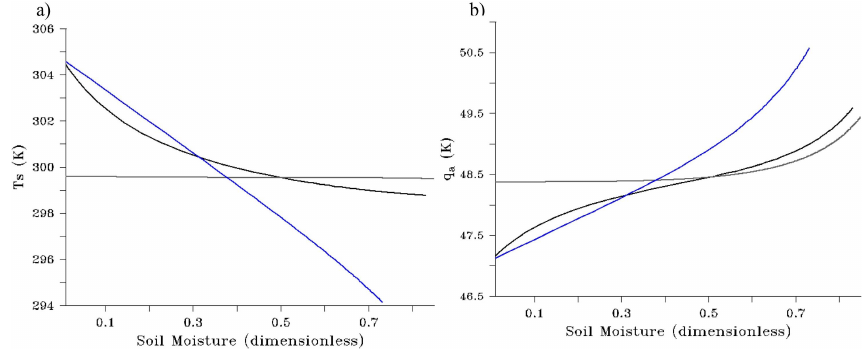
Figure 5. Comparison of prototype (a) surface temperature T s and (b) surface air humidity q a for the baseline (black), fixed β (gray), and fixed E p (blue) configurations of the prototype. Note that q a is converted to temperature units of K.